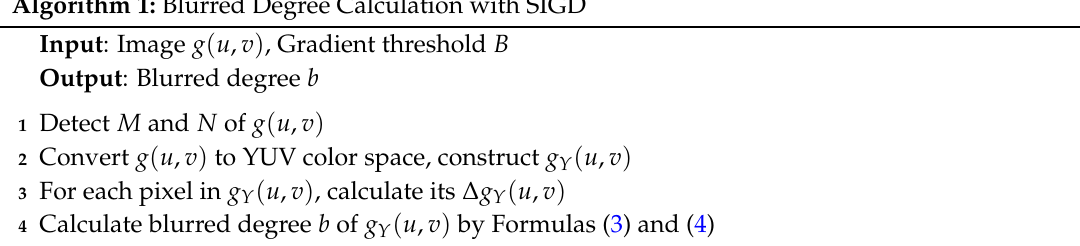
Algorithm 1: Blurred Degree Calculation with